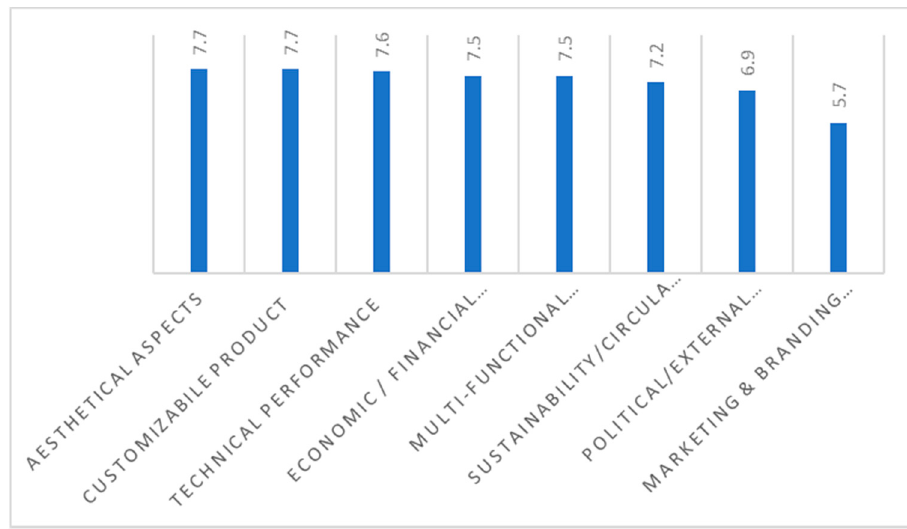
Figure 3. Decision-making